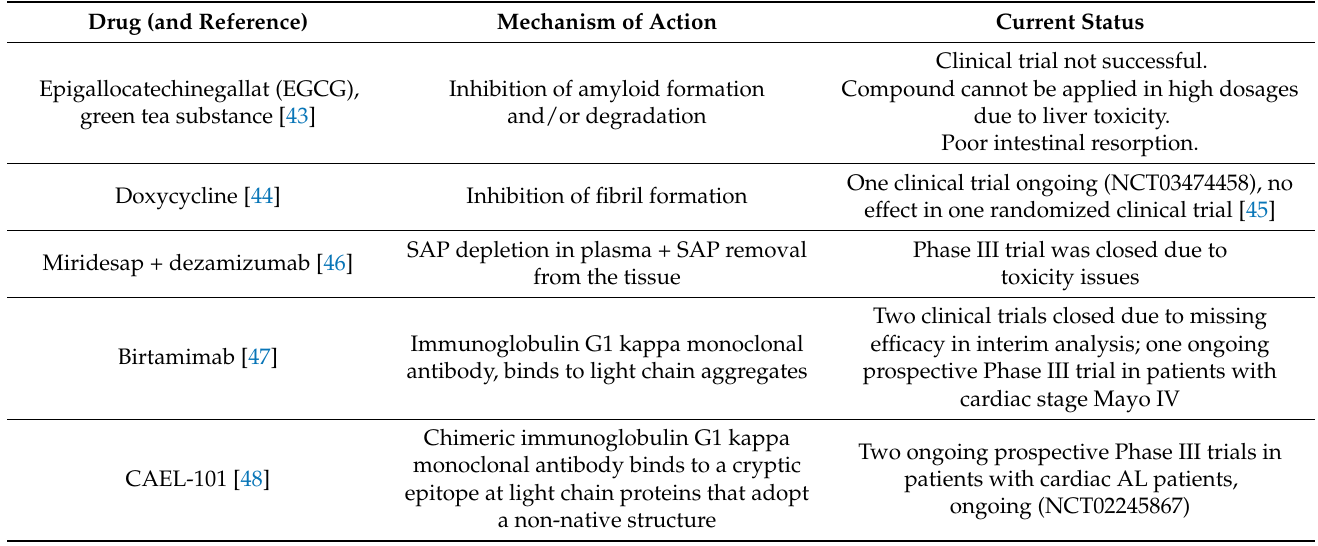
Table 4. Summary of drugs for anti-amyloid